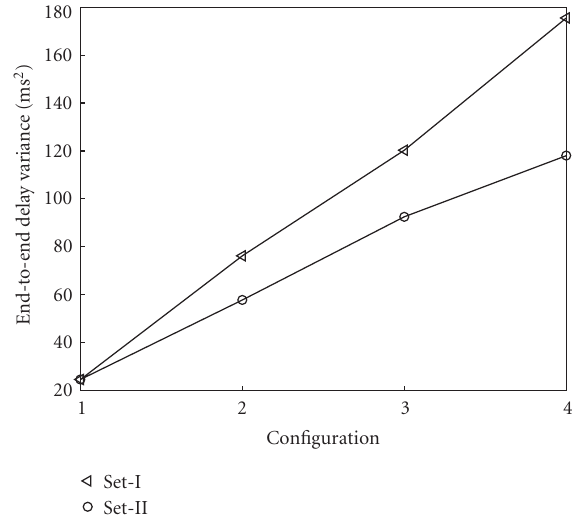
Figure 15: Measurement results on the packet delay variance.